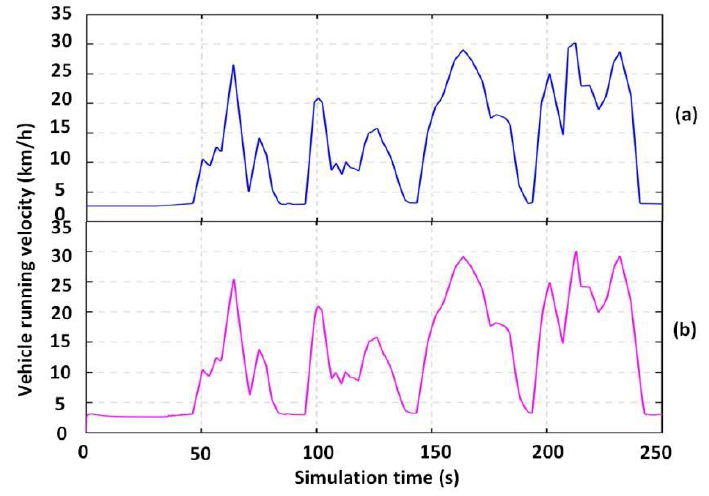
Figure 13. The velocity change curves of both actual working conditions ( a ) and the algorithm proposed in this paper ( b ).